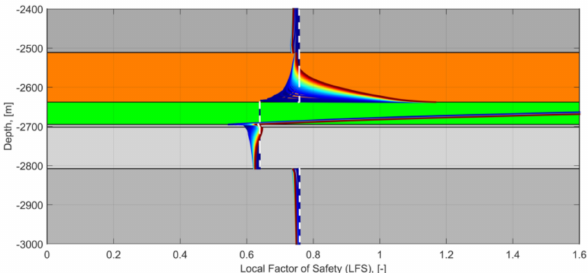
Figure 12. Local Factor of Safety (LFS), profiles along the left boundary, from zero to 50 years (blue to red coloured curves), initial profile is white dashed line. LFS < 1 indicates a stable